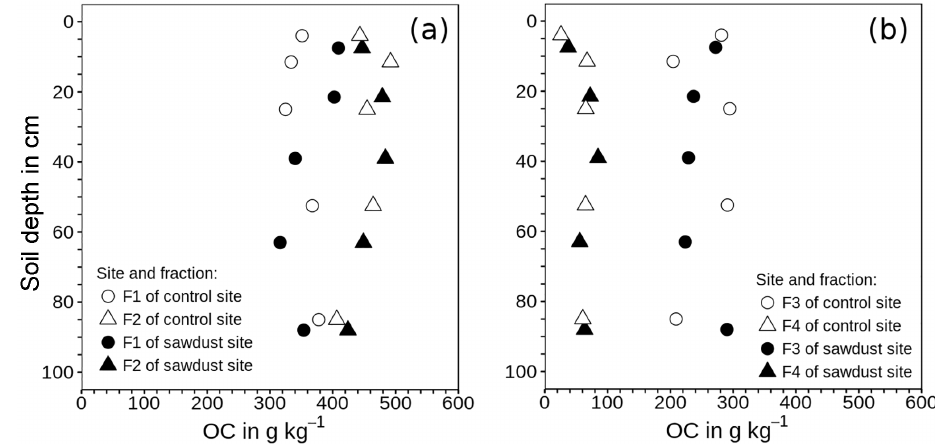
Figure 3. Mean of organic carbon (OC) concentrations in density fractions one to four related to the mass of the respective fraction instead of the bulk soil mass. (a) Fraction 1 (F1) contains material released directly; fraction 2 (F2) represents material released after applying 300JmL − 1 sonication energy. (b) Fractions 3 and 4 comprise organic matter strongly bound to mineral phases in soil particles of densities between 1.6 and 2.0gcm − 3 (F3) and >2.0gcm − 3